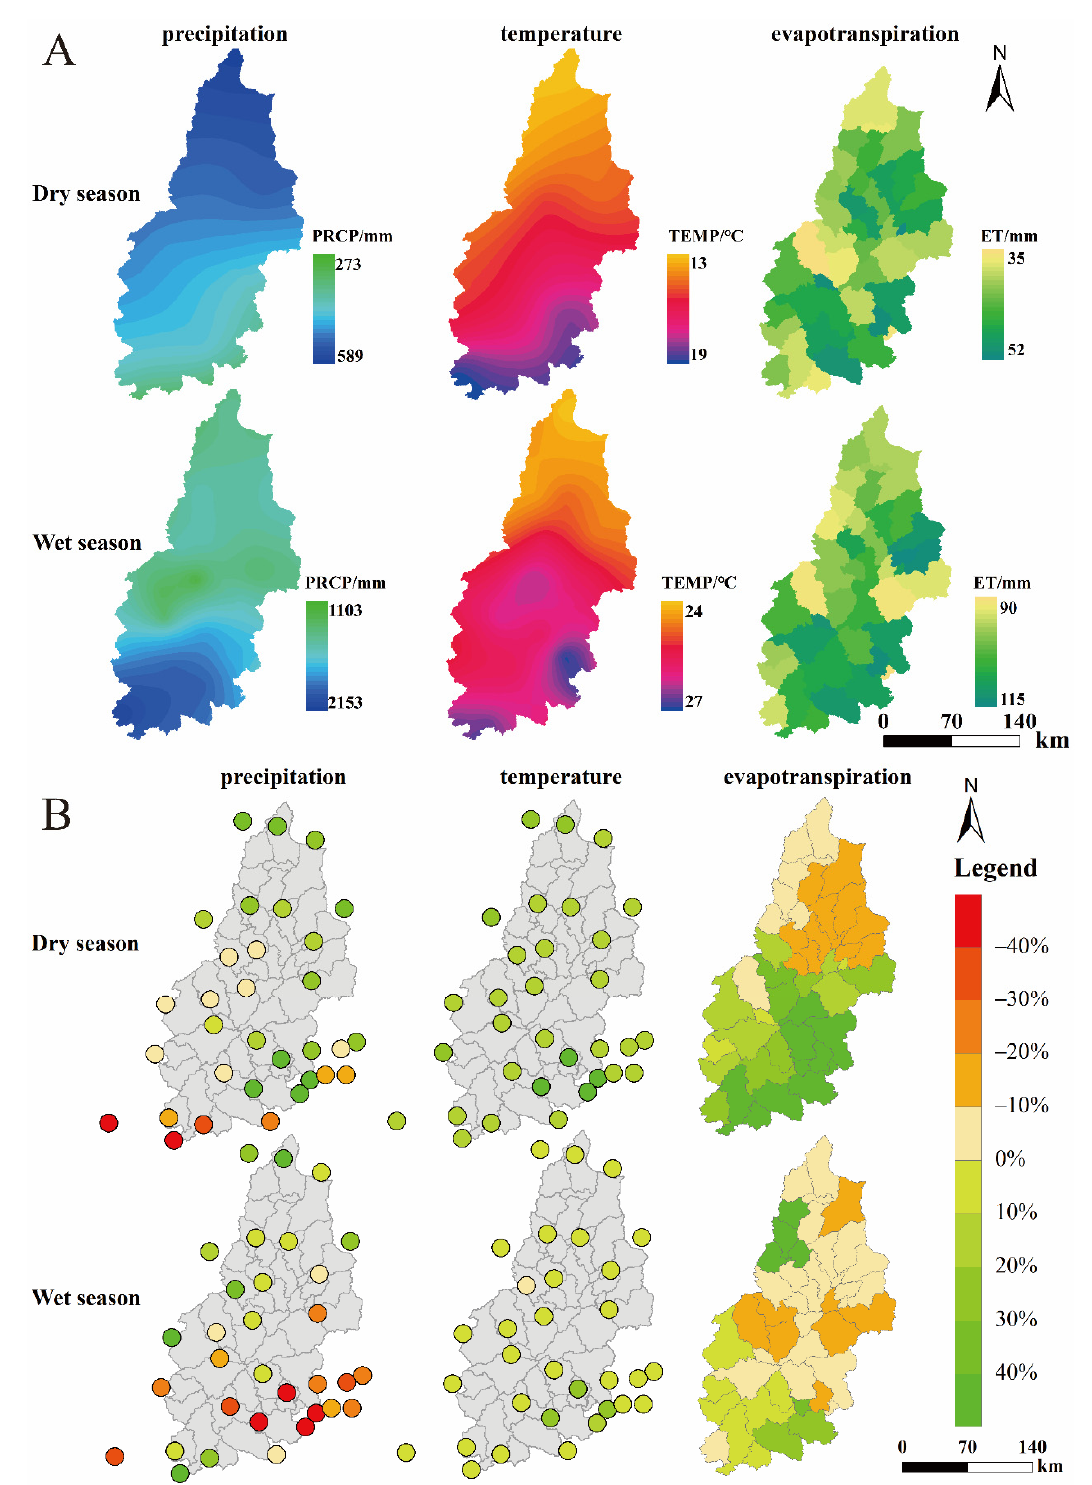
Figure 8. The distribution pattern ( A ) and relative changes ( B ) of major meteorological elements under climate change in the watershed.